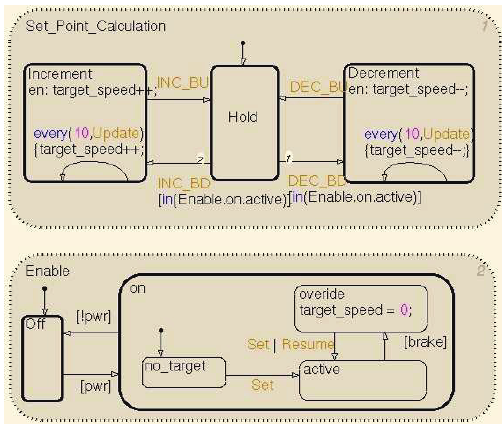
Fig. 2. Simulink stateflow model of a cruise control.